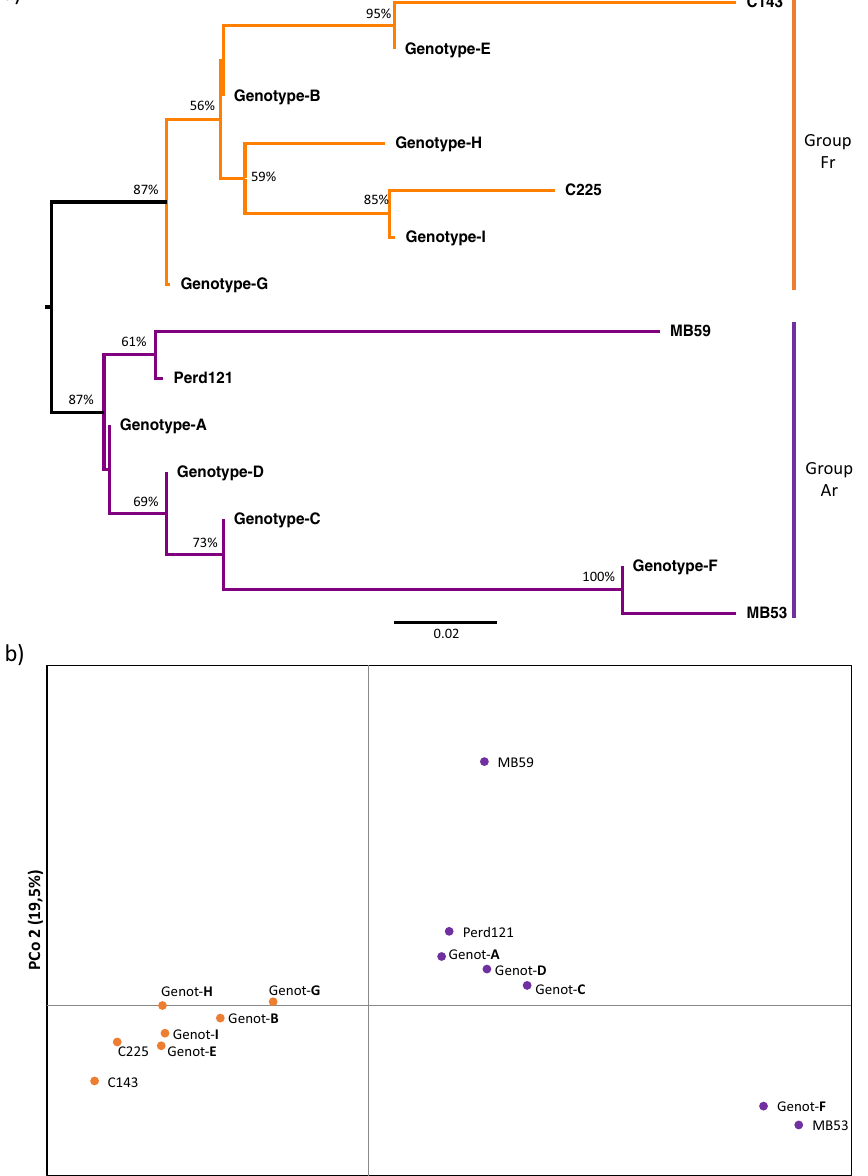
Figure 4. The phylogenetic relationships and genetic distance among the identified genotypes (based on 41 SNVs) suggest the existence of two clonal lineages in Malbec. ( a ) Neighbor-joining tree based on p -distances, bootstrap supports values > 50% are shown. The orange clade (Group-Fr) included genotypes closely related to the resequenced accessions that have long remained in Europe (C143 and C225). The purple clade (Group-Ar) included genotypes closely related to the resequenced accessions with more than 70 years of clonal propagation in Argentina (MB53 and MB59). ( b ) Principal coordinates analysis (PCoA) based on genetic distances. PCoA retrieved the same relations as the phylogenetic analyses performed among the genotypes identified, differentiating between Group-Ar (purple) and Group-Fr